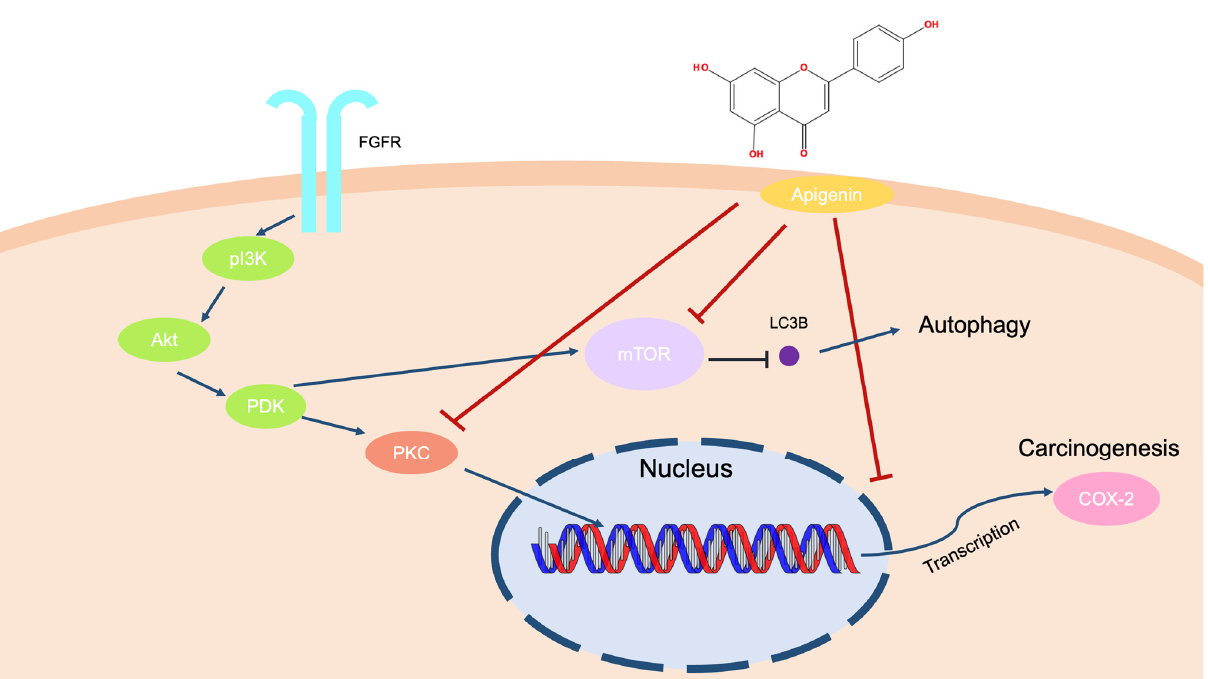
Figure 7. Mechanism of anti-carcinogenesis effects according to apigenin treatment in an NMSC